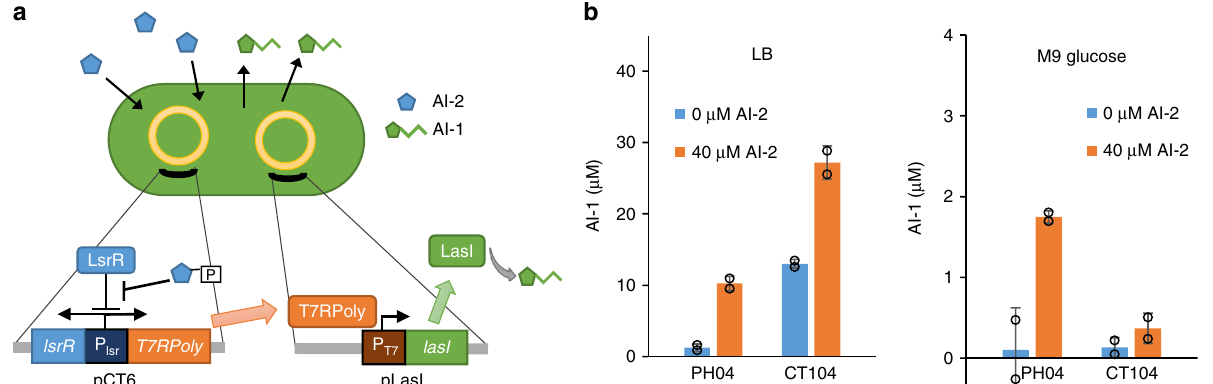
Fig. 4 Engineered translator cells produce AI-1 in response to AI-2. a Translator cells couple the AI-2 and AI-1 quorum sensing circuits using a dual plasmid system. Phosphorylated AI-2 activates expression of T7 RNA polymerase and subsequent expression of LasI which synthesizes AI-1. b AI-1 produced by CT104 pCT6 pLasI or PH04 pCT6 pLasI grown in different media with and without AI-2 addition. AI-2 was added as indicated at ~OD 0.1 and samples for AI-1 measurement were taken 6 h later. Error bars represent s.d. between technical duplicates. Source data are provided as a Source Data fi